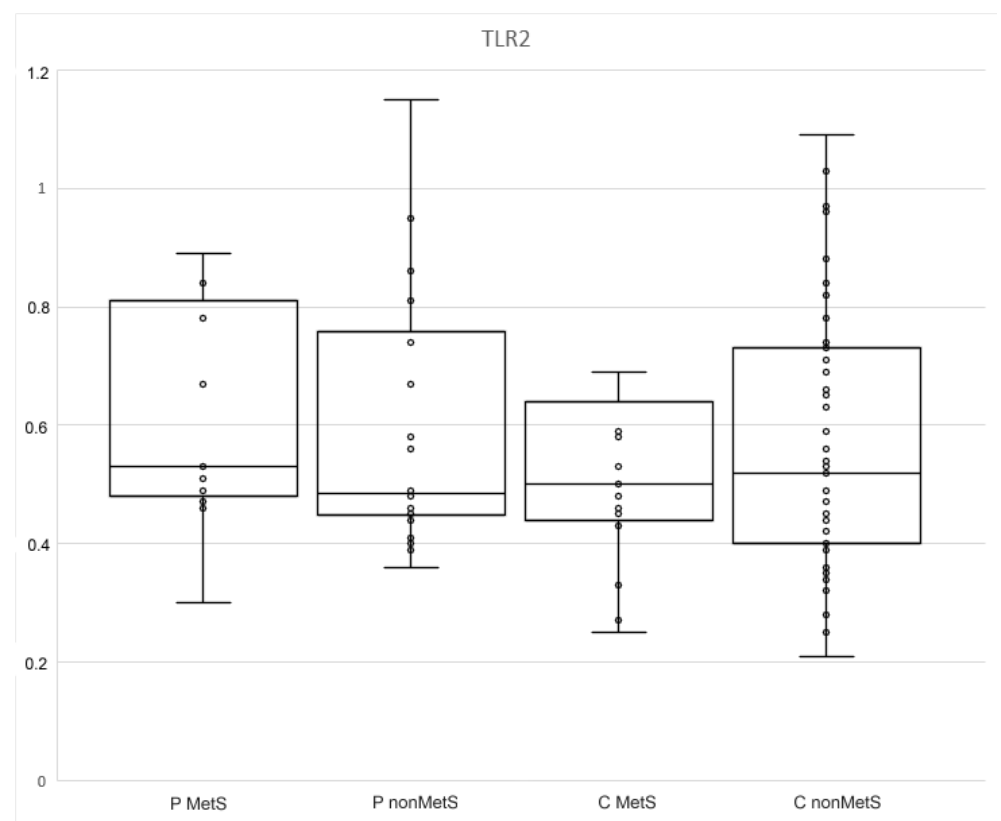
Figure 4. The levels of sTLR2 in MetS and nonMets patients and controls. In the group of patients, the negative correlations between CD5L and CD200R1 and between PASI and age, and positive correlations between CRP and BMI, CD5L and BMI, and PASI and age were identified (Spearman correlation −0 .39, p < 0.05; SC: −0 .3, p < 0.05; SC: 0.58, p < 0.002; SC: 0.37, p < 0.01). The only correlation in the controls was CRP and BMI (SC: 0.26, p < 0.02). The subgroup analysis revealed two correlations in controls and three in patients. The correlation between CRP and BMI in nonMetS controls, and between CD5L and age in MetS controls (SC: 0.33, p < 0.02; C MetS SC: 0.48, p < 0.03), were detected. There were correlations between CD200R1 and TLR2, and between BMI and CRP, in nonMetS patients (SC:0.43, p < 0.02; SC: 0.66, p < 0.002). In MetS patients, a negative corre- lation between CRP and TLR2 was found (SC: −0 .45, p < 0.02) (Figure 5).